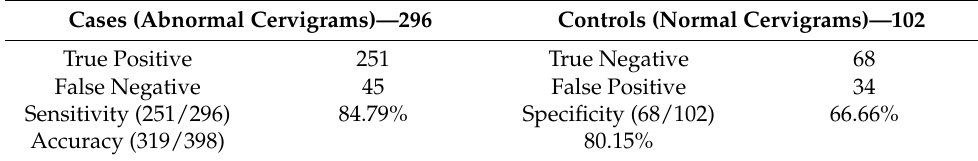
has produced promising results, with 84.79% sensitivity, 66.66% specificity, and 80.15% accuracy.